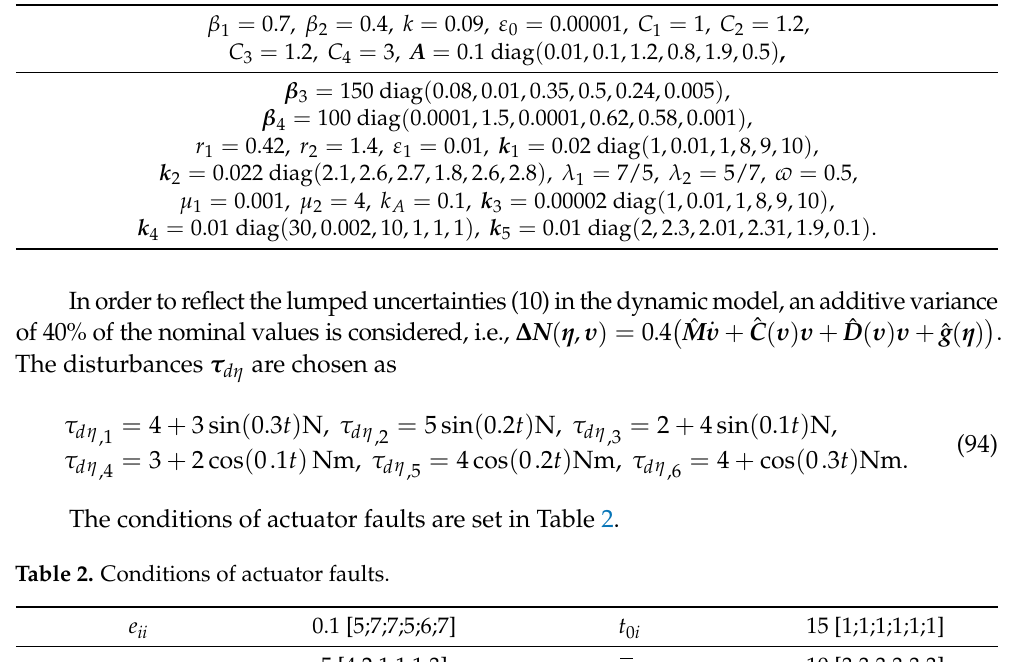
Figure 11. The flow field characteristics of hydrothermal plume. Table 1. Control parameters for the FTFTARSMCer.